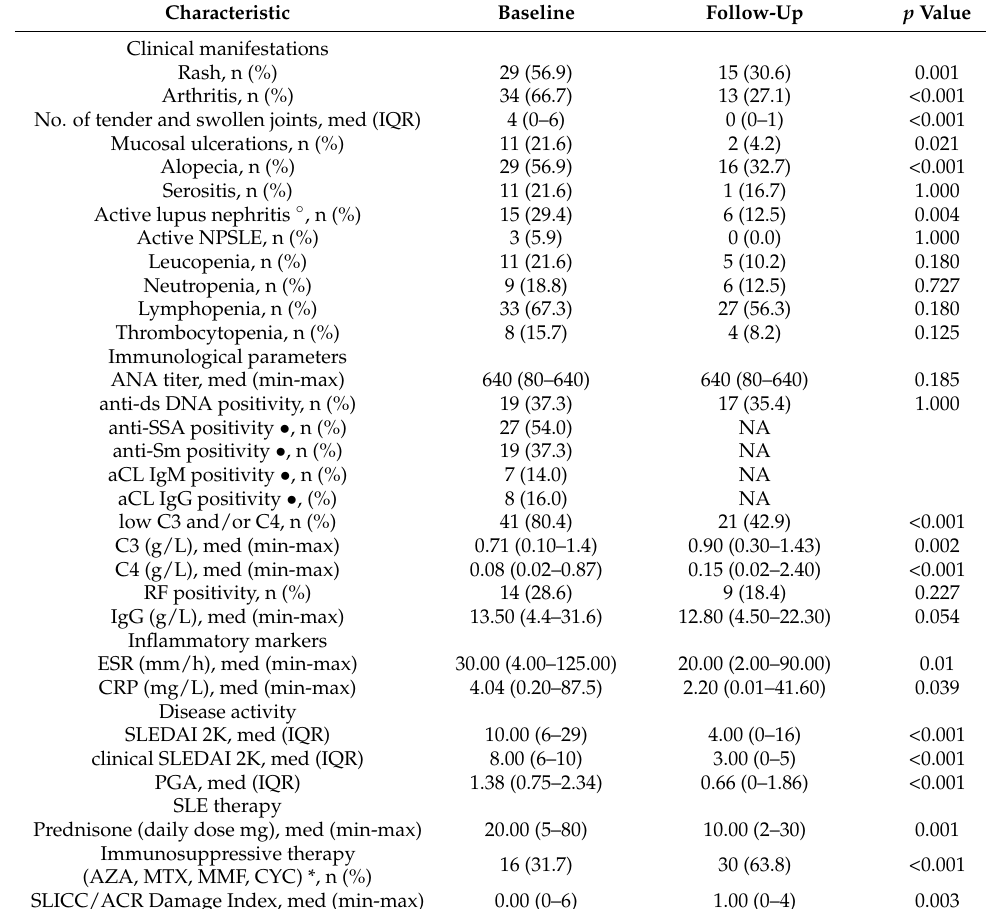
Table 1. Characteristics of the study population during the follow